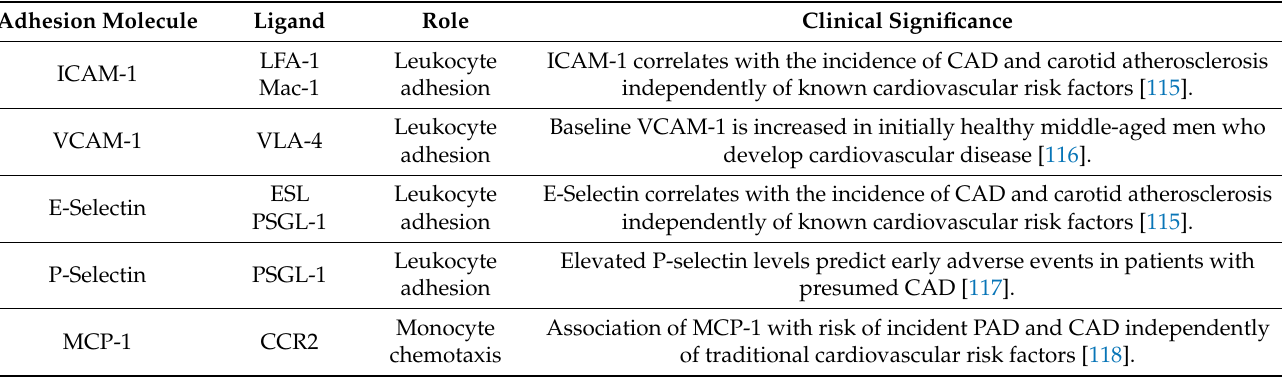
ICAM-1: Intercellular adhesion molecule-1, VCAM-1: vascular cell adhesion molecule-1, MCP-1: monocyte chemoattractant protein-1, LFA-1: leukocyte function-associated antigen-1, VLA-4: very late antigen-4, ESL: E-selectin ligand, PSGL-1: P-selectin glycoprotein ligand-1, CCR2: C-C chemokine receptor type 2, CAD: coronary artery disease, PAD: peripheral arterial